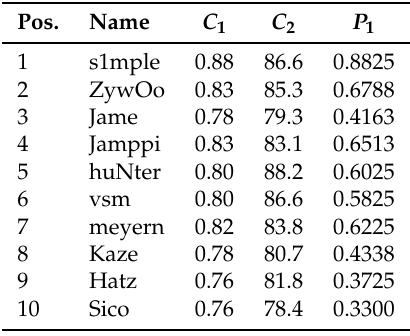
Table 4. The performance table of the selected criteria C 1 , C 2 and assessment model P 1 .